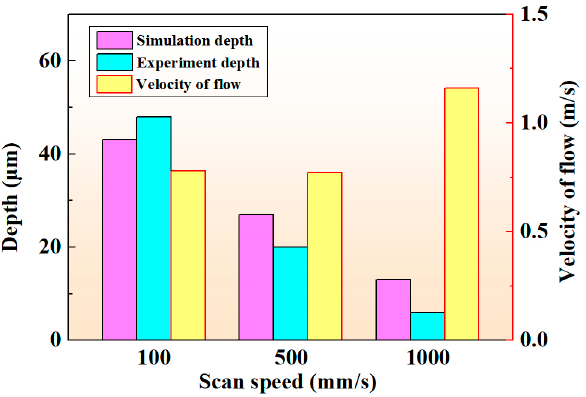
Figure 10. The comparison results of laser ablation depth and the variation of the flow velocity at di ff erent scanning speeds.